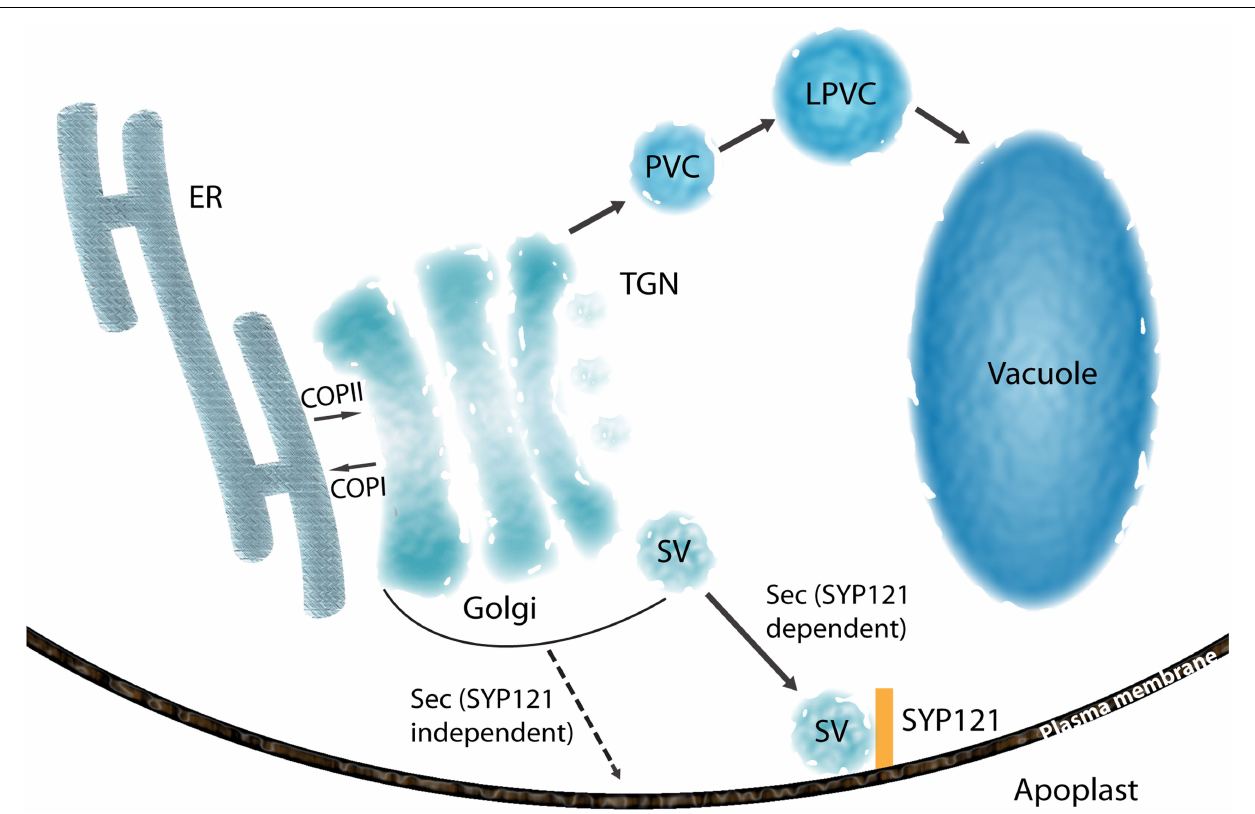
FIGURE 2 | Overview of the secretory pathway of glycosylated proteins. Glycosylated proteins are transported from ER to cis -Golgi by either bulk flow transport or receptor mediated transport. COPII and COPI proteins are involved in anterograde and retrograde trafficking between ER and Golgi, respectively. Secretory and vacuolar proteins are sorted atTGN.Vacuolar